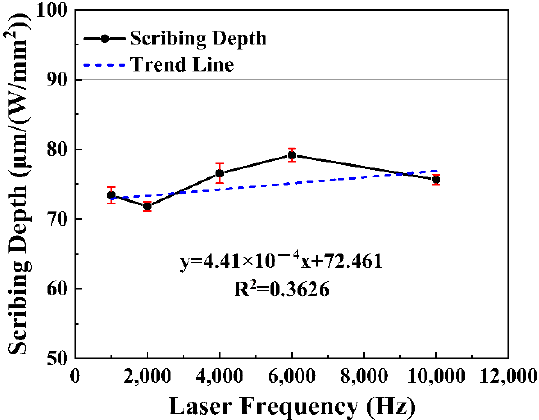
Figure 14. Relationship between laser frequency density and scribing depth.